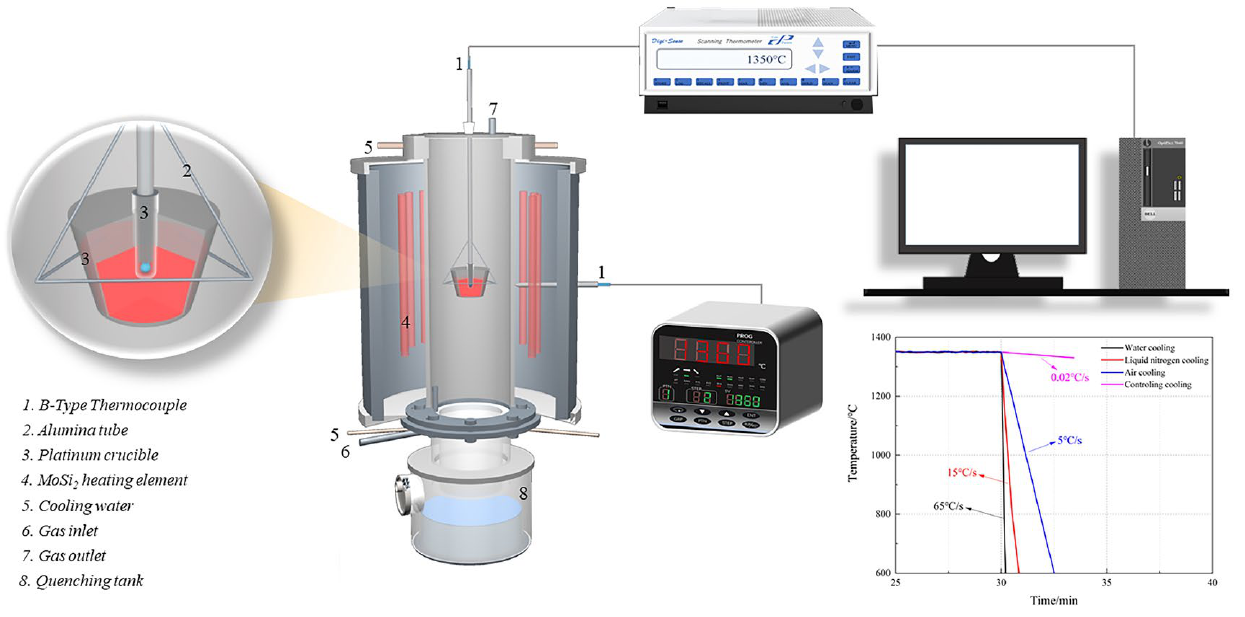
Figure 1. Schematic diagram of cooling crystallization device.